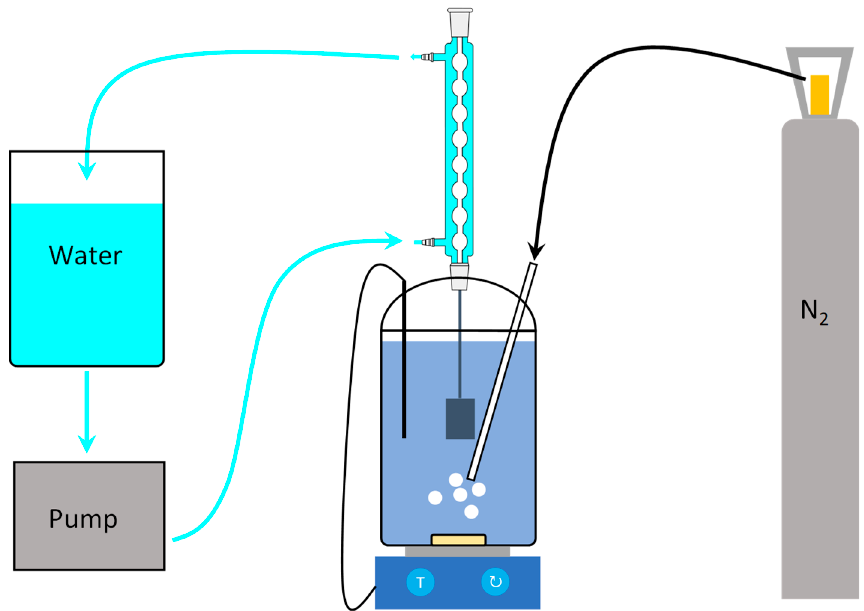
Figure 3. Schematic representation of the coating set-up.